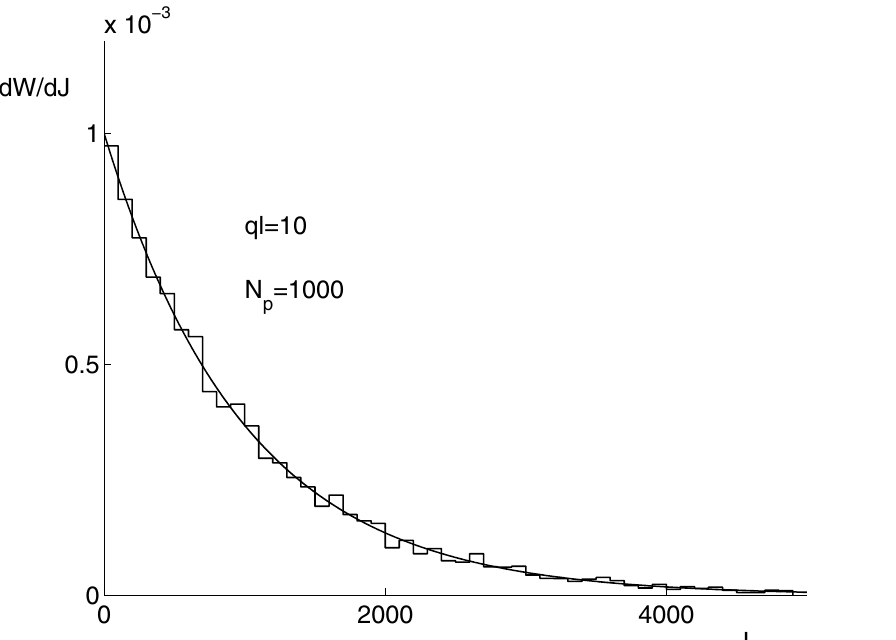
FIG. 6. A comparison of the analytical and numerical calculations for distributions (96). The curve is given for dW=dJ in (cid:7) 10 3 . The histogram represents the result of numerical calculations for distribution of J accordance with Eq. (96) at ql (cid:7) 10 , N p =l g defined in (82) and (90) for 10 4 various sets of random numbers f z a